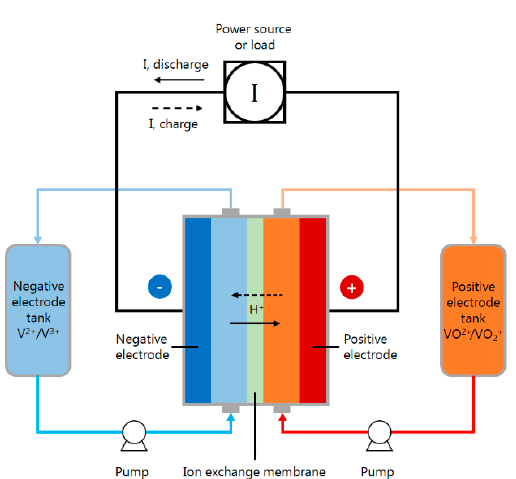
Figure 1. Schematic diagram of the vanadium redox flow battery (VRFB) system, adapted from [7].